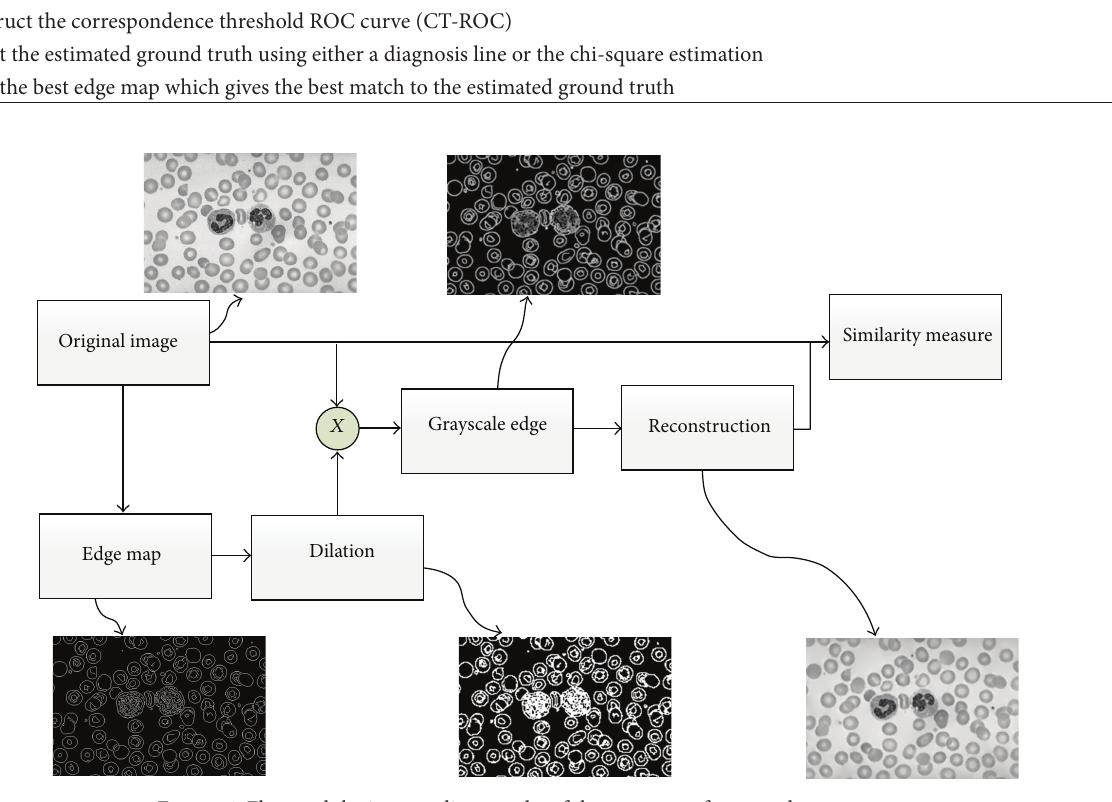
Figure 1: Flow and the intermediate results of the new nonreference edge